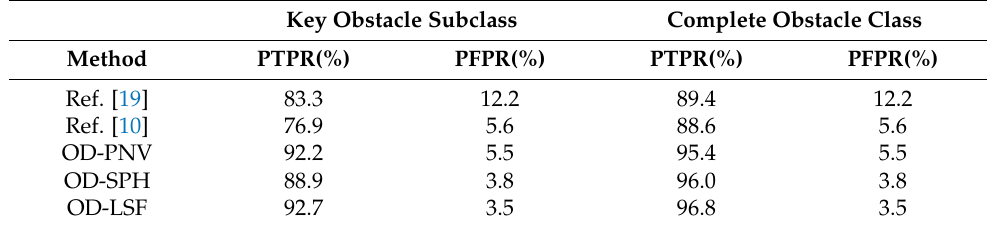
Table 1. Detection performance indicators of the five methods. Key Obstacle Subclass Complete Obstacle Class